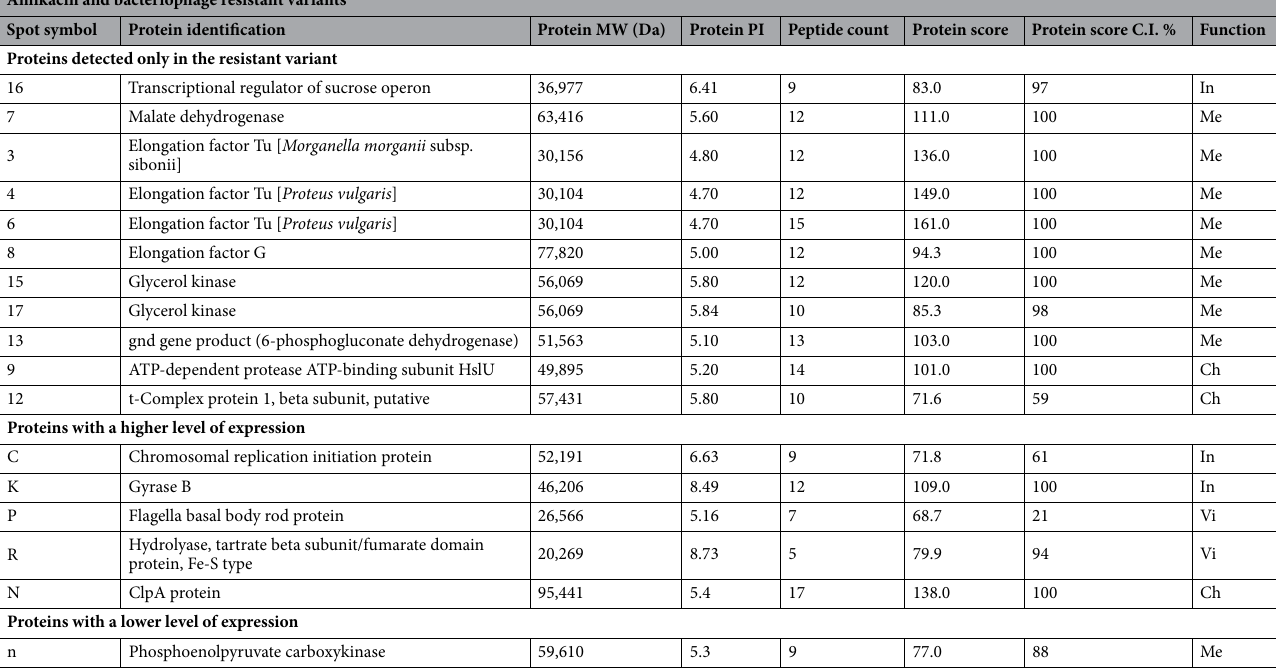
Table 4. Description of proteins specific to studied P. mirabilis 3059 amikacin and bacteriophage resistant variant (AMK/Brsv) identified by MALDI TOF MS/MS. Protein function: In information pathways, Me metabolism, Tr transport, Vi virulence, Ch chaperone. Spots marked with numbers indicate proteins which were detected only in the studied resistant variants. Spots marked with capital or lowercase letters correspond to proteins with a higher or lower level of expression in the resistant variants,